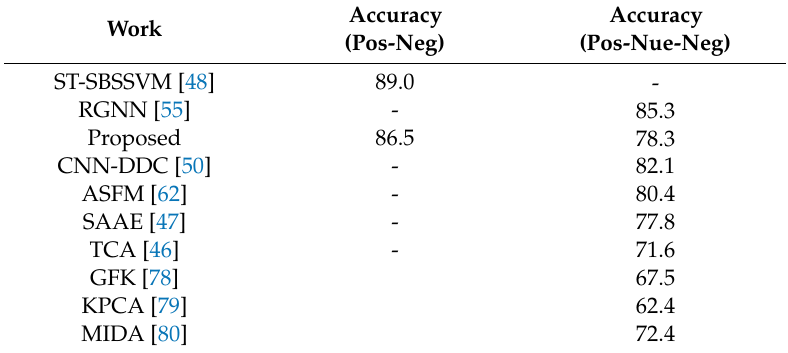
Table 4. “One-subject-out” prediction accuracies of reference studies using the SEED dataset.